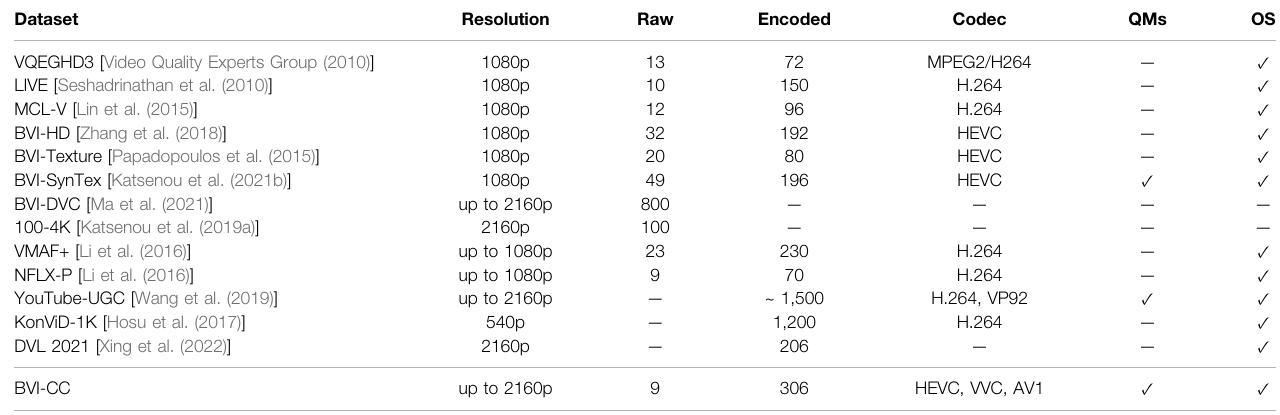
TABLE 1 | Selection of state-of-the-art datasets for video research purposes.